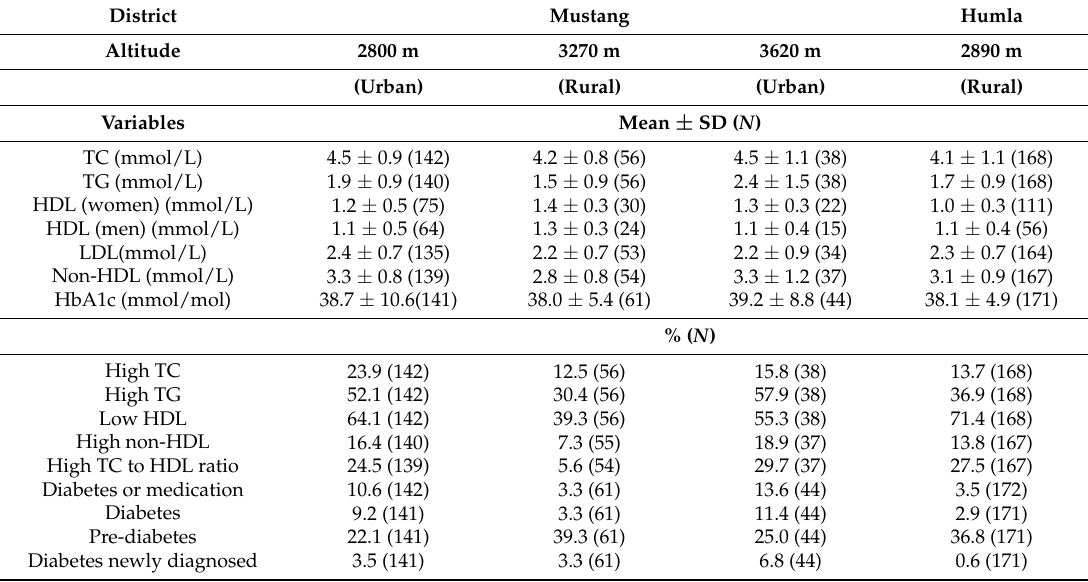
Table 2. Lipid profiles, HbA1c and diabetes related characteristics of the participants at each altitude level. District Mustang Humla Altitude 2800 m 3270 m 3620 m 2890